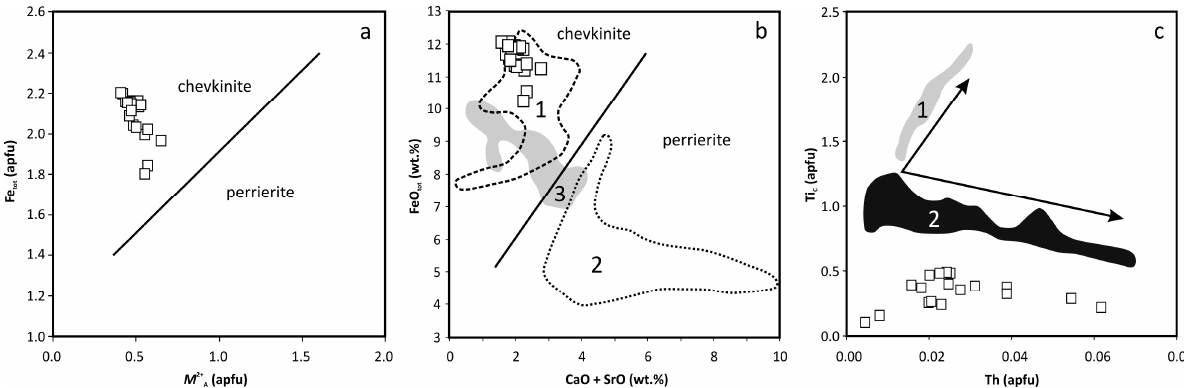
Figure 6. ( a , b ) Chevkinite-perrierite discrimination diagrams [26,27] with fields for non-altered chevkinite (1), perrierite (2), and hydrothermally altered chevkinite and perrierite (3) from A-type syenites and granites of Brasil [28]. ( c ) Correlation between titanium and thorium contents (apfu), illustrating compositional trends in post-magmatic (2) and primary magmatic (1) chevkinite [28]. Squares are projection points of chevkinites from Pinciná.